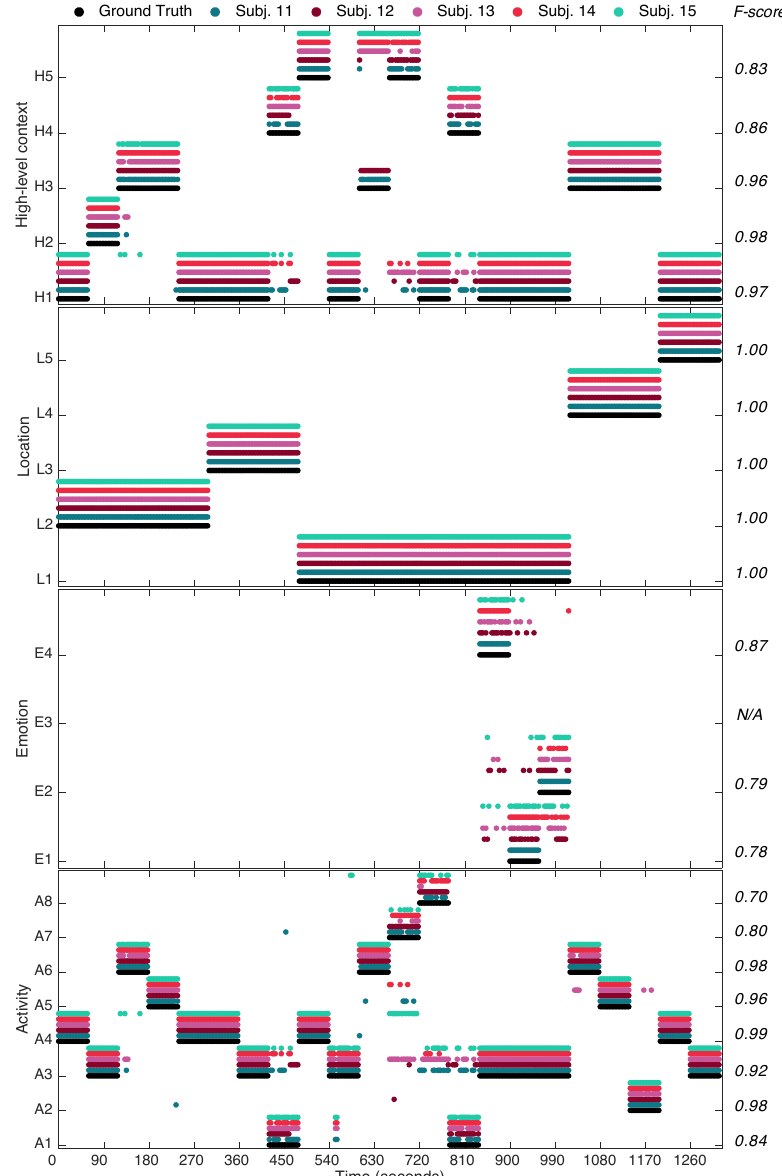
Figure 10. Low- and high-level contexts detected by the multimodal context mining system during online evaluation for the subjects S11–S15. Actual contexts are given by the ground-truth labels. Overall performance for each context and across all subjects is given by the corresponding